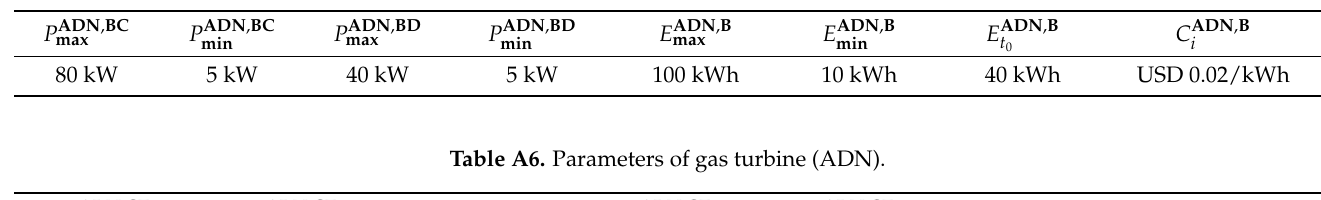
Table A5. Parameters of energy storage system (ADN).